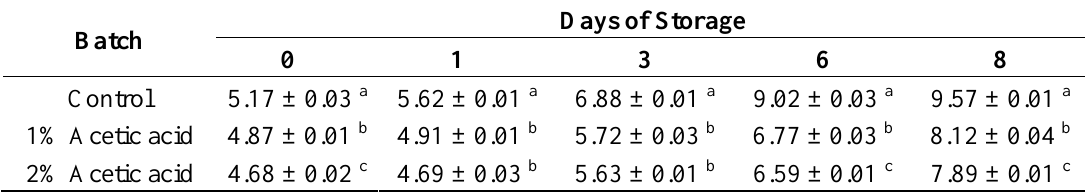
Table 2. The effect of acetic acid on the psychrotroph counts on poultry legs (log CFU/g).